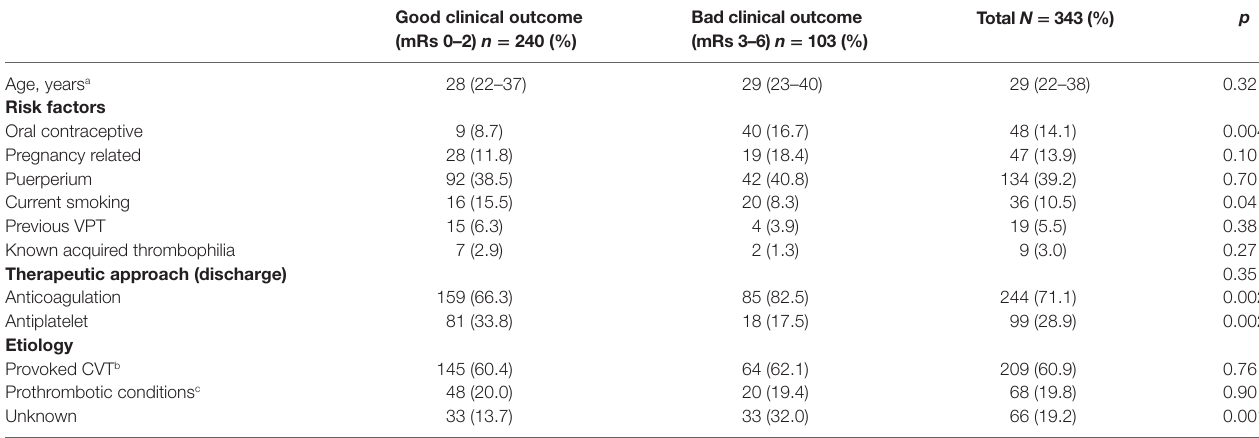
TaBle 3 | General features and vascular risk factors according to clinical outcome at discharge modified Rankin scale (mRs) in patients with cerebral venous thrombosis.